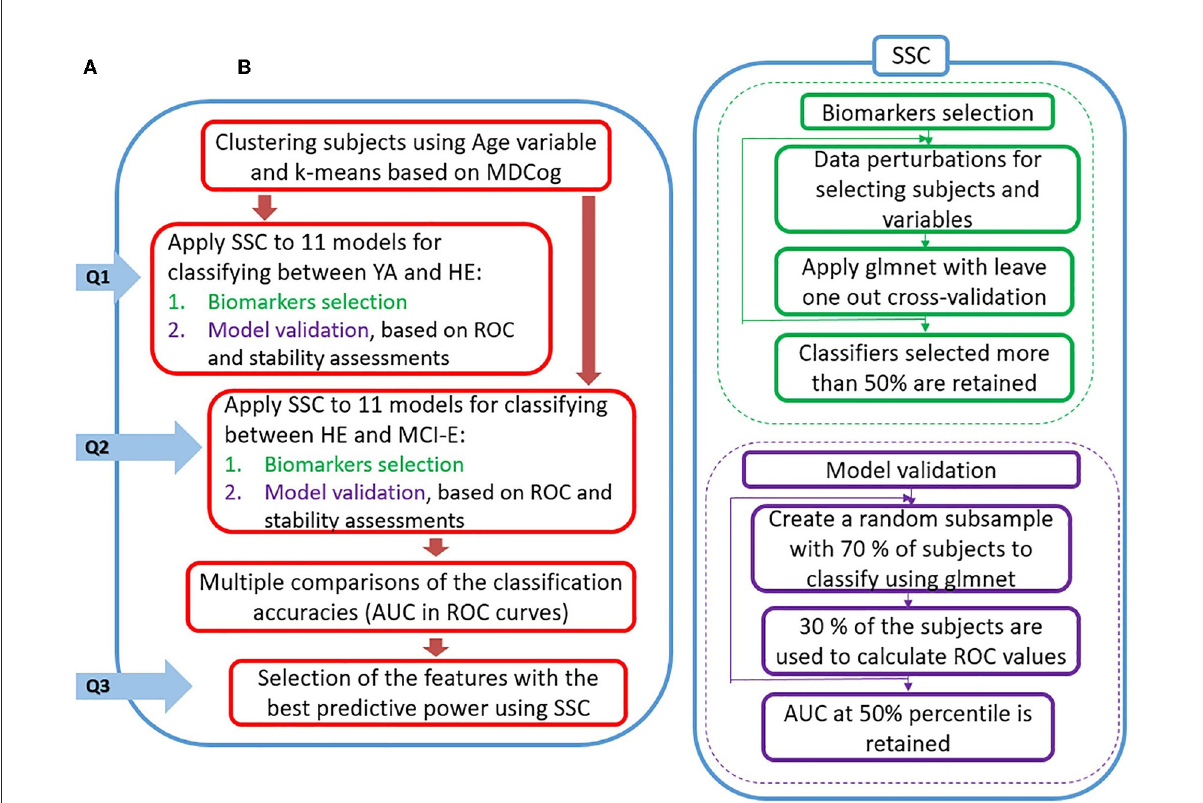
FIGURE1 Analysis flow aimed to address the objectives of the work. (A) Questions derived from the goals of the study: Q1. Can SSC on STGF predict the mild cognitive changes present in healthy older adults compared to young adults? Q2. Can SSC on STGF predict the cognitive changes present in cognitive impaired older adults compared to healthy older adults? and Q3. Can SSC on STGF identify the best combination of walking tasks and associated STGF to predict cognitive status? (B) General description of the methods used to answer the questions and their